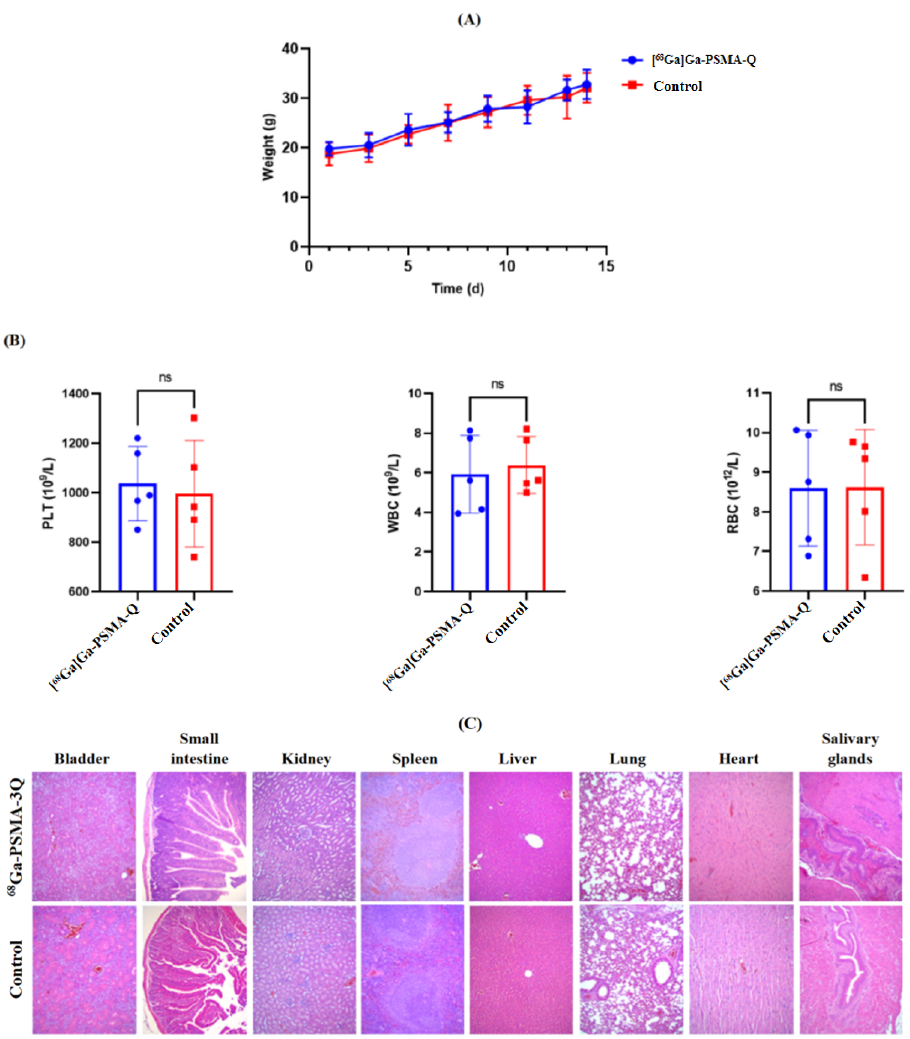
Figure 9. Radiotoxicity evaluation of [ 68 Ga]Ga-PSMA-Q (37 MBq/mouse) in ICR mice ( n = 5/group). ( A ) The weight changes of mice injected with [ 68 Ga]Ga-PSMA-Q or saline (control) in the radiotoxicity study period. ( B ) Results of routine blood tests of mice in the [ 68 Ga]Ga-PSMA-Q and control groups. ( C ) Results of H&E staining of the main organs (i.e., kidneys, heart, liver, spleen, salivary glands, small intestine, bladder, lungs) of mice in the [ 68 Ga]Ga-PSMA-Q and control groups (WBC: white blood cell count, PLT: platelet count, RBC: red blood cell count. Values are expressed as the mean ± SD; n = 10; ns: not statistically significant).